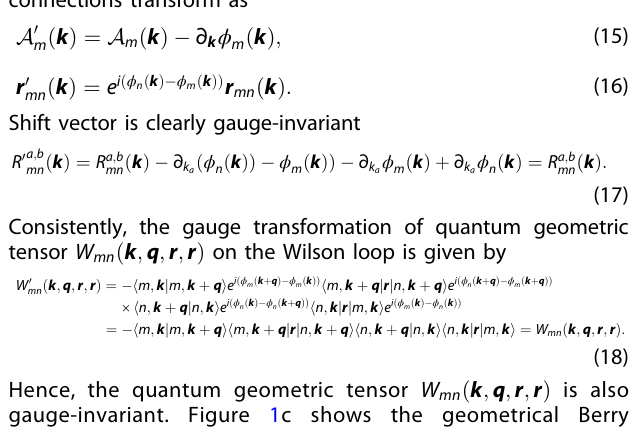
Fig. 1 Wilson loop approach of the Berry curvature and geometrical shift vector. a Berry curvature Ω z k ð Þ represented by the overlap matrix elements between Bloch wavefunctions U at neighboring k -points. The Wilson loop is W n k ð Þ ¼ hU 1 jU 2 ihU 2 jU 3 ihU 3 jU 4 ihU 4 jU 1 i . b Shift vector k ð Þ along q between band m and n represented by Bloch wavefunctions U at neighboring k -points and transition matrix elements r R mn Wilson loop for shift vector W mn k ð Þ ¼ hU 1 jU 2 ihU 2 j r jU 3 ihU 3 jU 4 ihU 4 j r jU 1 i is associated with the interband transition. c , d Physical meaning of shift vector. The integral of the Wilson loops results in the polarization difference between two bands upon optical transition and the relative shift of the charge center of the wave packet involving a pair of